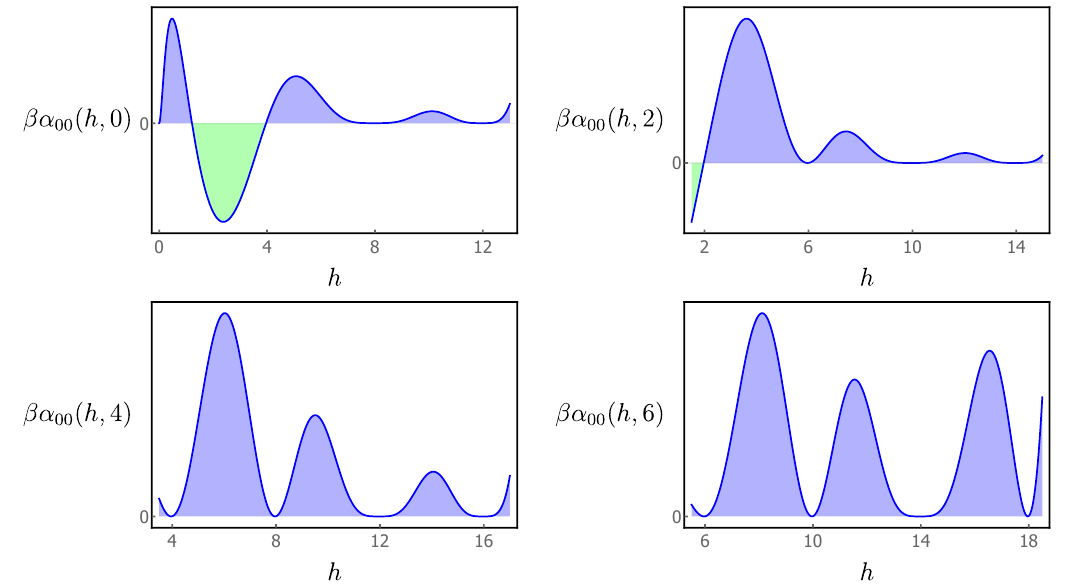
Figure 3 . Functional actions (cid:12)(cid:11) 00 ((cid:1) ; ‘ ) for various spins and (cid:1) (cid:30) = 1. For ‘ = 0 the functional becomes positive when (cid:1) > 4. Similarly there is a (cid:12)rst order zero at (cid:1) = ‘ = 2. These imply that for (cid:1) (cid:30) = 1 there must be at least one scalar operator with dimension smaller or equal to four, and higher than (cid:24) 1 :